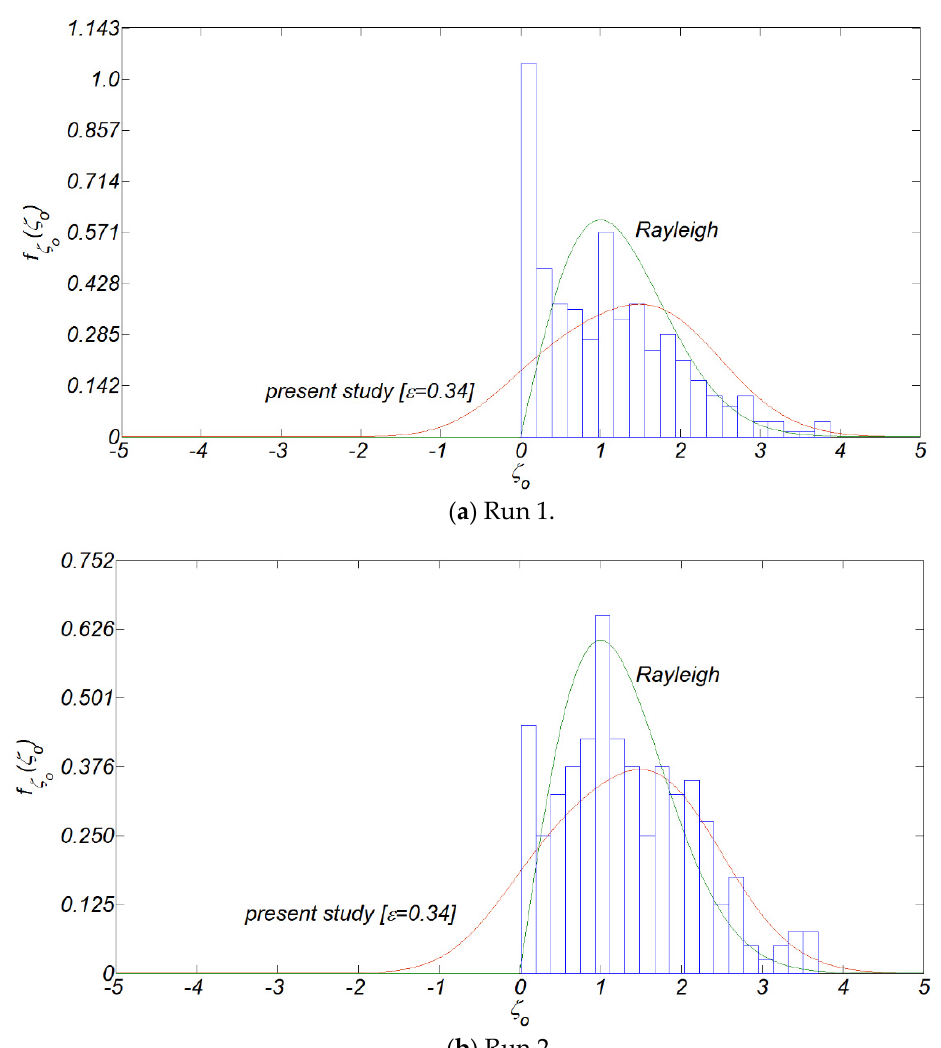
Figure 5. Comparison of wave crests distribution with Rayleigh distribution and measured data.